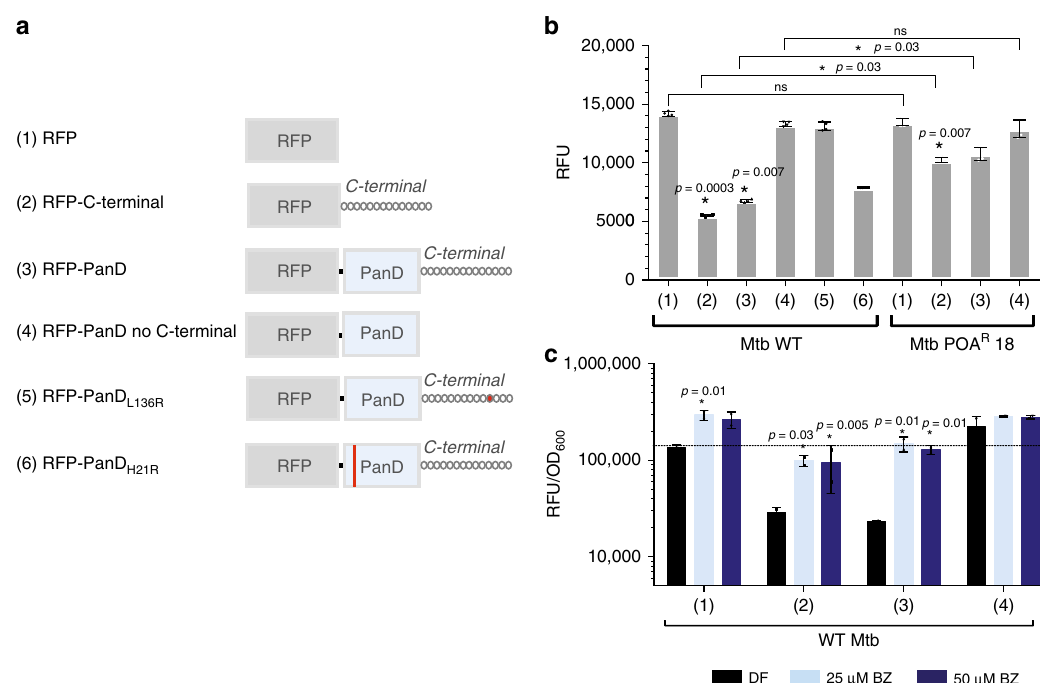
Fig. 2 Effect of fusion of various PanD derivatives on the level of RFP reporter protein. a Schematic of derivatives of PanD fused translationally to constitutively expressed red fl uorescence protein (RFP) as episomal reporter on plasmid pMV262 and transformed into Mtb. C-terminal = mycobacterium-speci fi c C-terminal tail of PanD. RFP – PanD L136R and RFP – PanD H21R are PZA/POA-resistant mutants harboring missense mutation in the N-terminal His21 or the C-terminal tail Leu136 (indicated in red) and have been described previously 4,6 . b Fluorescence levels (expressed as RFU, relative fl uorescence units) of mid-log phase cultures (OD 600 = 0.2) were determined as a measure of intrabacterial fusion protein level in either Mtb wild- type (WT) or PZA/POA-resistant mutant Mtb POA R 18 [ clpC1 : Lys209Glu] 7 harboring RFP – PanD reporter constructs shown in a . One-way ANOVA multiple comparisons test (Dunn ’ s posttest, GraphPad Prism) was used to compare fl uorescence levels conferred by the various constructs relative to the native RFP in wild-type background (left cluster 1 – 6) and in clpC1 mutant background (right cluster 1 – 4), respectively; * p value < 0.05; ns p value > 0.05. The two-sided Mann – Whitney test (GraphPad Prism) was used to compare fl uorescence levels conferred by each RFP construct in the clpC1 mutant versus wild-type background (horizontal bars placed across left and right clusters). * p value < 0.05; ns p value > 0.05. c Effect of bortezomib (BZ) on fl